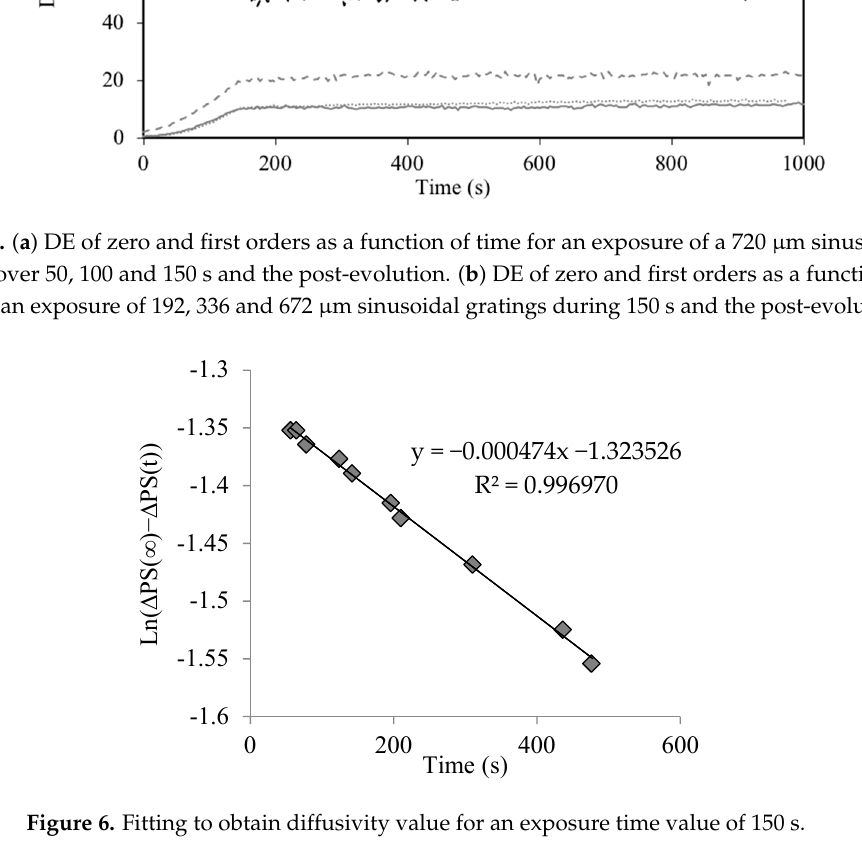
Figure 6. Fitting to obtain diffusivity value for an exposure time value of 150 s.